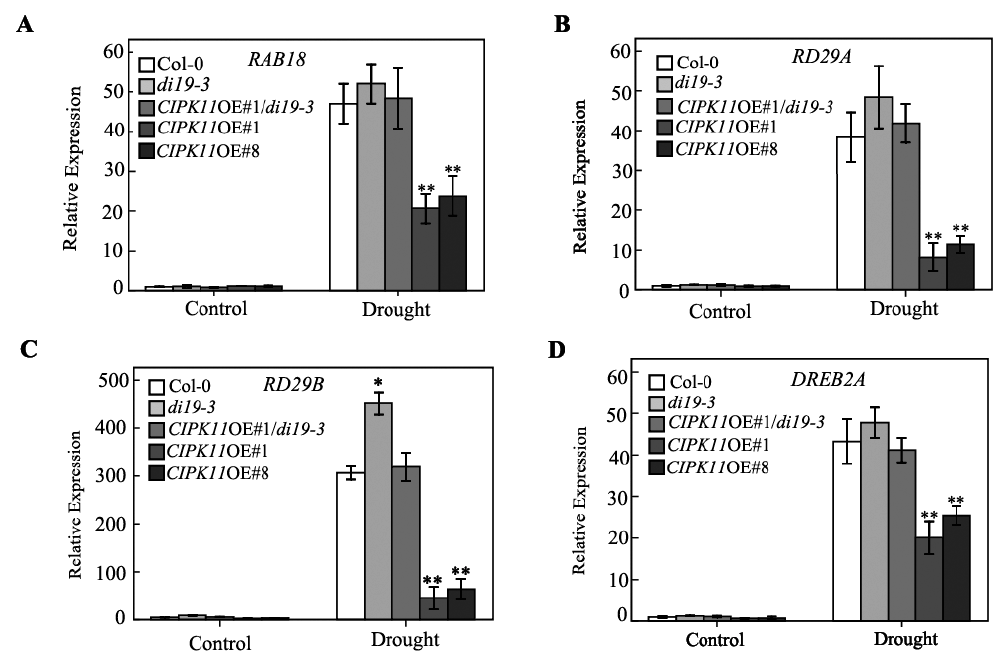
Figure 6. Expression profiles of the drought stress-responsive genes in Col-0, di19-3 , CIPK11 OE#1 / di19-3 , CIPK11 OE#1, and CIPK11 OE#8 in response to drought stress. Relative expression levels of the drought stress-responsive genes RAB18 ( A ), RD29A ( B ), RD29B ( C ), and DREB2A ( D ) in Col-0, di19-3 , CIPK11 OE#1 / di19-3 , CIPK11 OE#1, and CIPK11 OE#8 plants under drought stress. Drought treatment was induced by withholding water for five days. The transcriptional levels were determined by qRT-PCR analysis. Values are the means ± SD ( n = 3). The Actin2 was used as an internal control. ** p < 0.001, Student’s t -test.